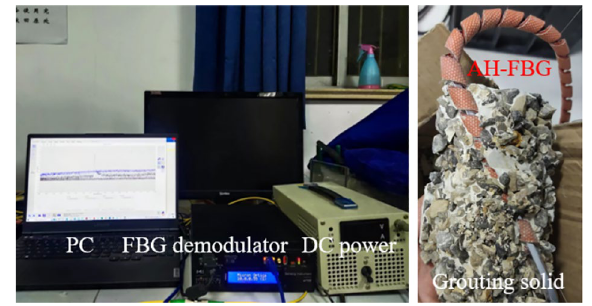
Figure 1. Monitoring